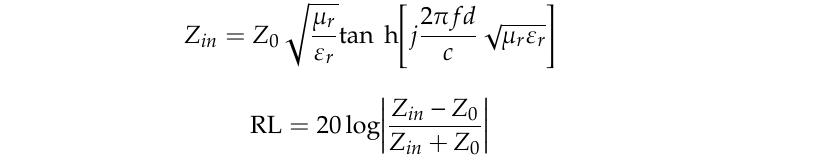
Figure 9. Reflection loss curves of S1 ( a ), S2 ( b ), and S3 ( c ); the effective absorption bandwidth of S2 ( d ).